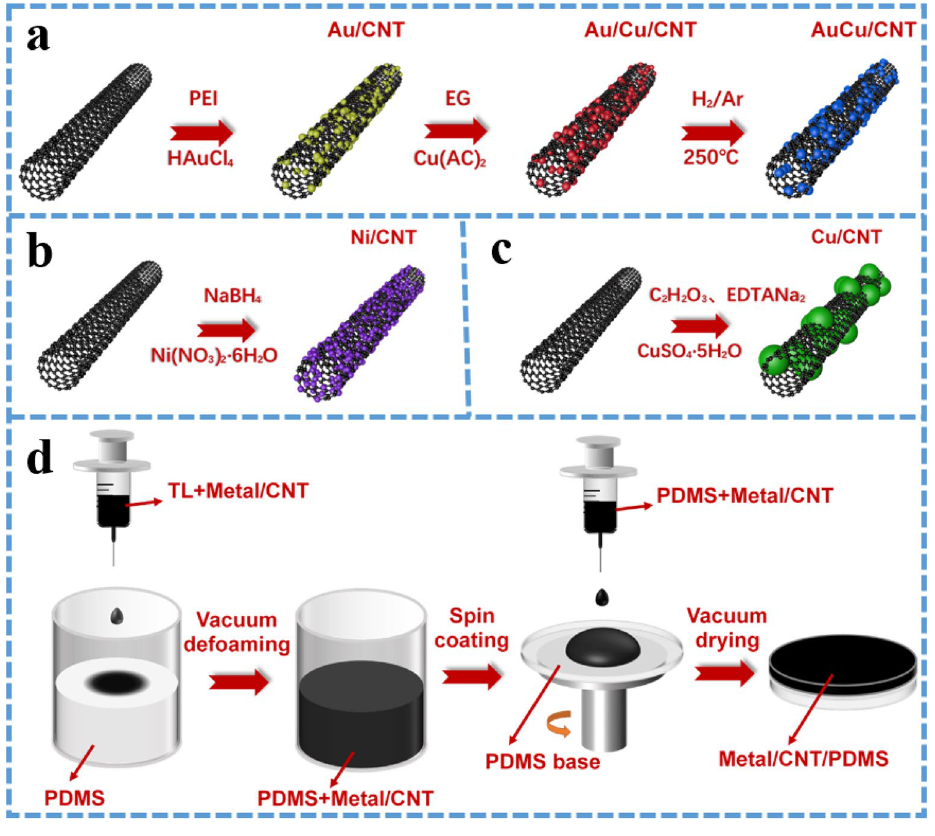
Figure 1. Schematic diagram of ( a ) Au/CNT and AuCu/CNT preparation process, ( b ) Ni/CNT preparation process, ( c ) Cu/CNT preparation process and ( d ) Metal/CNT/PDMS films preparation